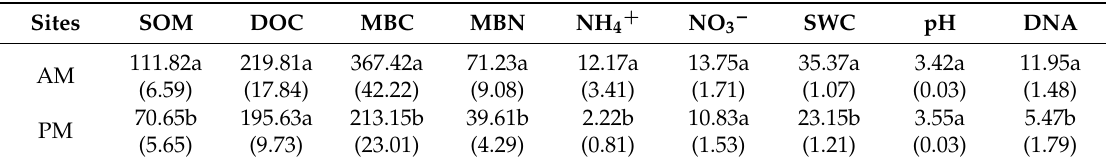
Abbreviations: SOM, soil organic matter (g kg − 1 ); DOC, dissolved organic carbon (mg C kg − 1 ); MBC, microbial